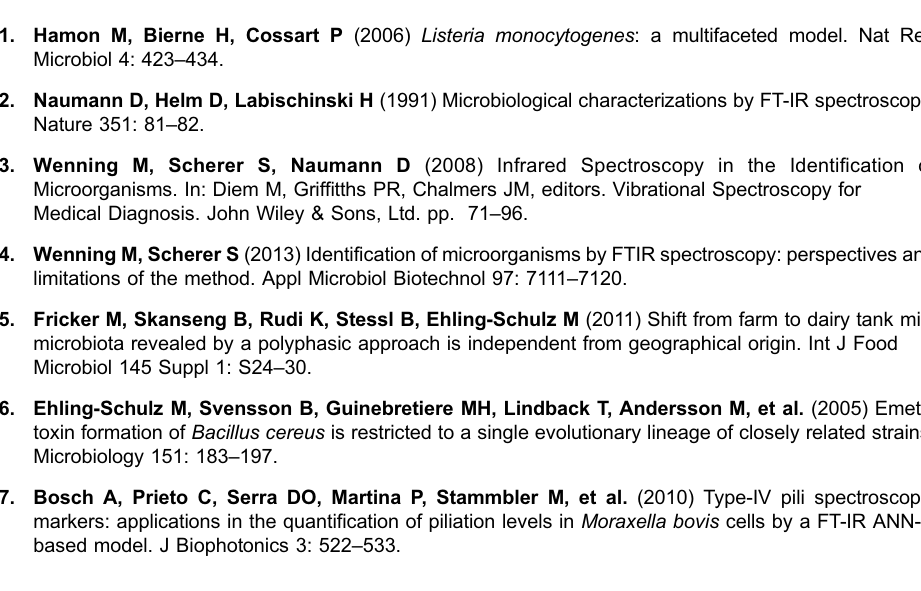
S1 Fig. Potential host memory effects on mice passaged L. monocytogenes isolates monitored by FTIR spectroscopy. PCA on second derivative, vector- normalized FTIR spectra from L. monocytogenes isolates derived from challenged 129/Sv (X), Tyk2 2 / 2 (O) and C57BL/6 ( + ) mice of the second experiment (A) directly after passage in mice and (B) after consecutive sub-cultivations at 37 ˚ C on laboratory standard media for three